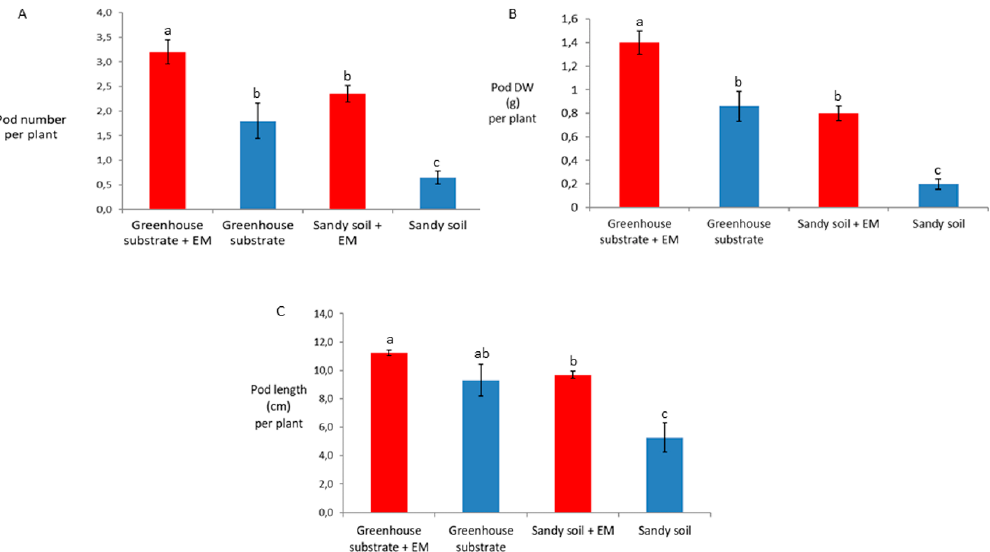
Figure 3. Pod yield. Effects of EM treatments on ( A ) pod number per plant, ( B ) pod dry weight (DW) per plant, and ( C ) pod length. Bean plants were grown on greenhouse substrate and sandy soil. Results are expressed as mean ( n = 15), and error bars indicate the SD. Significant differences were accepted at p < 0.05 and represented by different letters, according to Tukey’s HSD test.